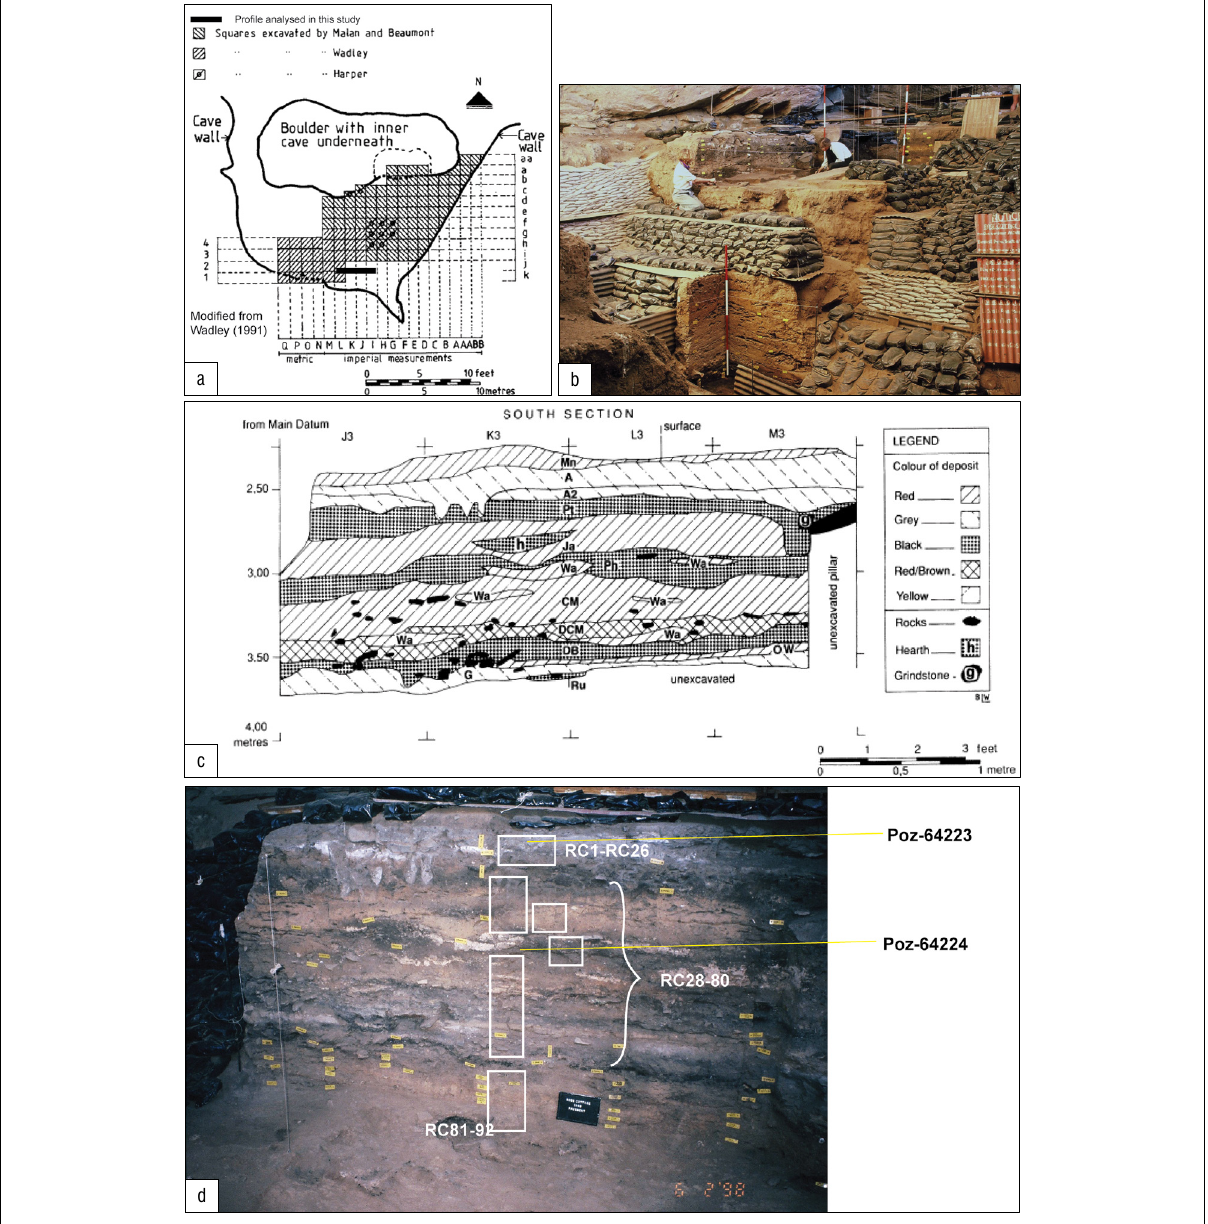
Figure 2: (a) Map of Rose Cottage Cave depicting the location of the palaeomagnetic study. (b) Lyn Wadley’s excavation at Rose Cottage. (c) Stratigraphic section showing the layers sampled in this study. (d) Picture of palaeomagnetic sampling in the southern